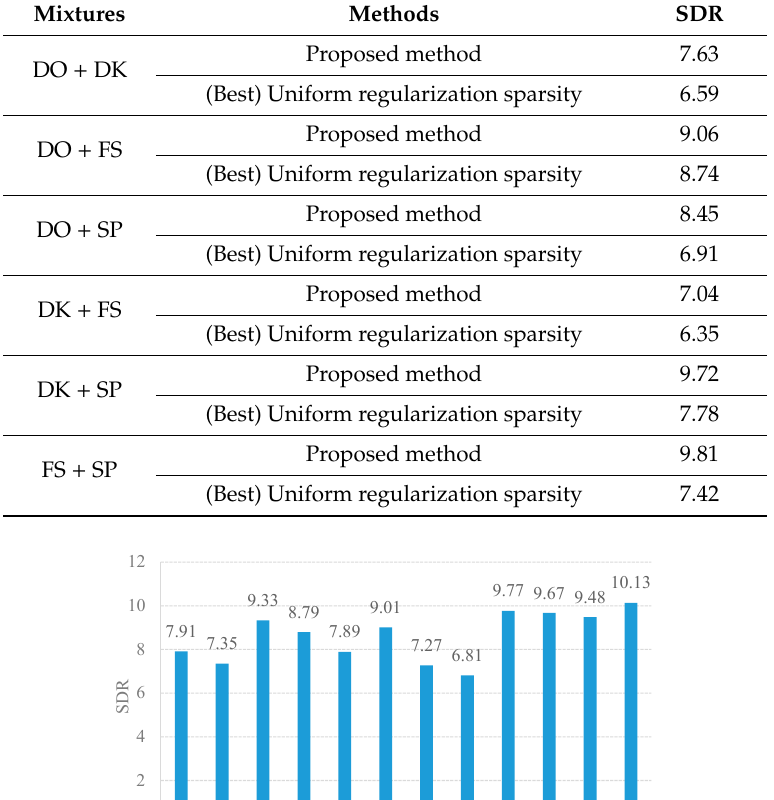
Table 1. Comparison of average SDR performance on three types of mixtures between uniform regularization methods and the proposed method.